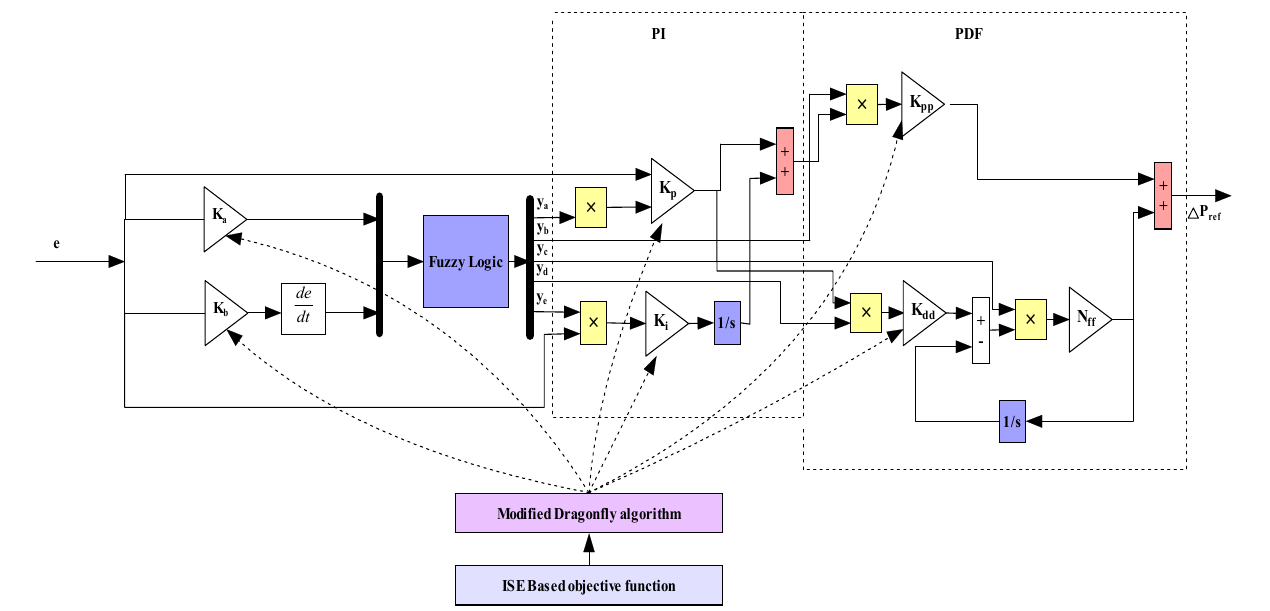
Figure 8. Proposed FLC-SF-PI-PDF controller structures.